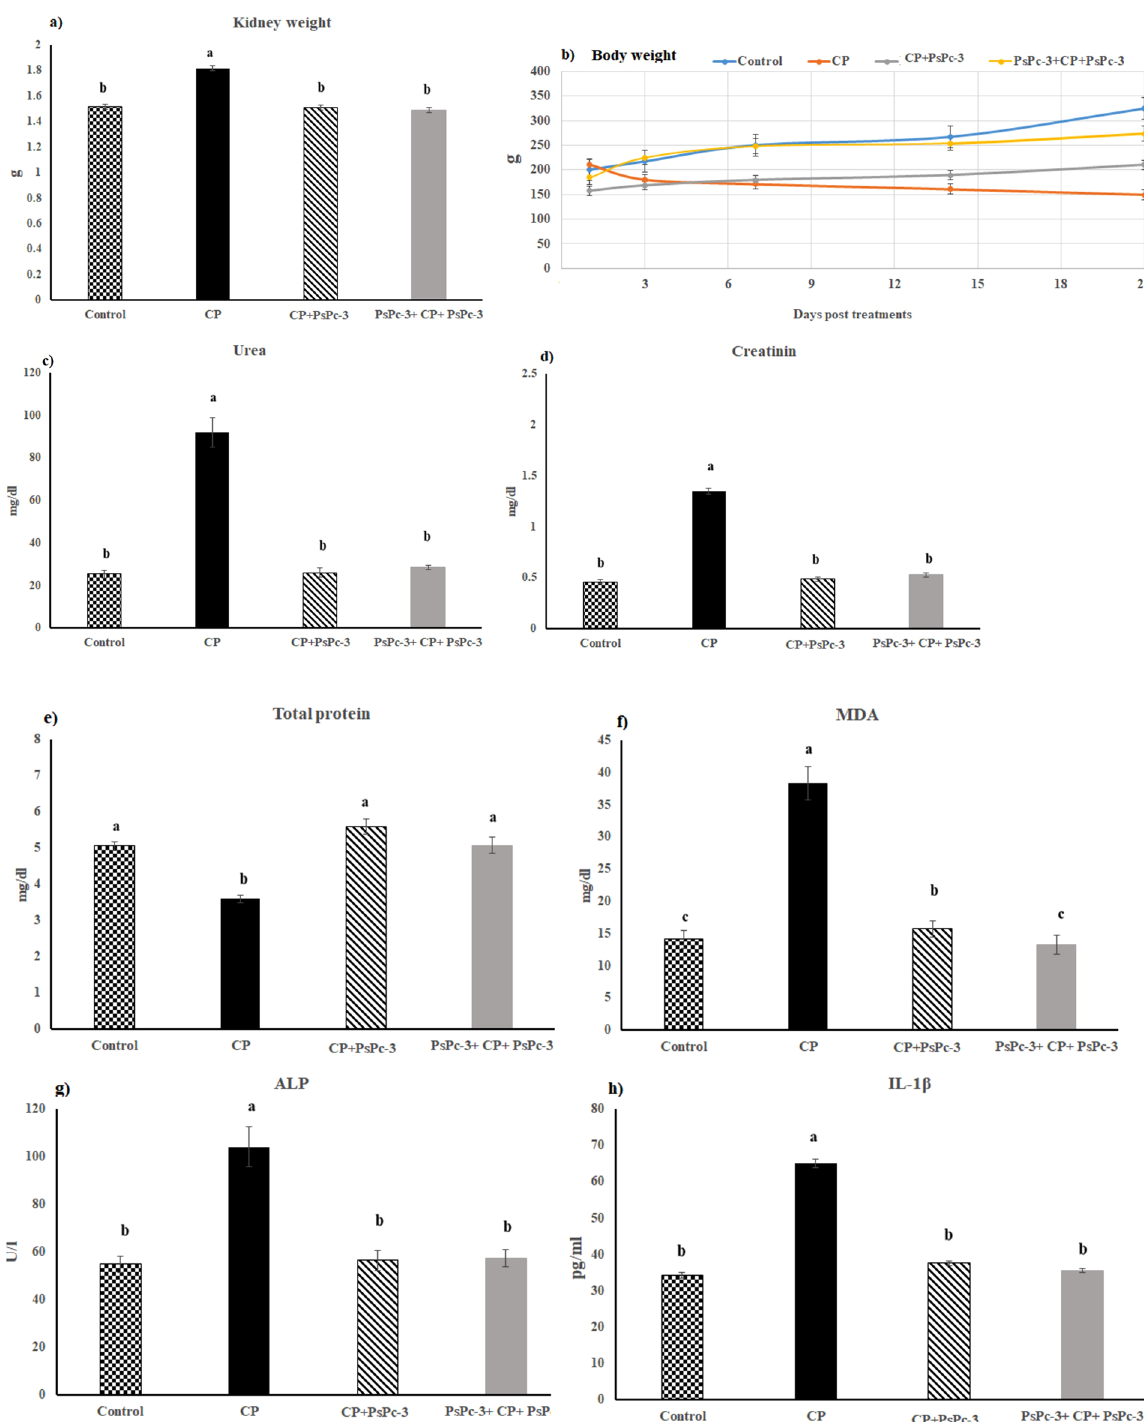
Figure 4. ( a ) Effect of PsPc-3 against CP on kidney weight, ( b ) Body weight, ( c ) Urea, ( d ) Creatinine, ( e ) Total protein, ( f ) MDA, ( g ) ALP, ( h ) Proinflammatory cytokines, i) MPO. The data are means ± SE ( n = 8). One-way ANOVA followed by Tukey’s multiple comparison post hoc test; the differences were considered significant at P ≤ 0.05. In the kidney weight, urea, creatinine, ALP, and proinflammatory cytokines ( a P < 0.05 versus Control, CP + PsPC-3, and PsPc-3 + CP + PsPc-3, b P > 0.05 vs. Control); in total protein ( a P > 0.05 vs. Control and P < 0.05 vs. CP only, b P < 0.05 vs. Control, CP + PsPC-3, and PsPc-3 + CP + PsPc-3. In MDA ( c P > 0.05 vs. Control, a P < 0.05 vs. Control, b P < 0.05 vs. CP alone treated group). Therefore, small letters (a, b, c) indicate a statistically significant